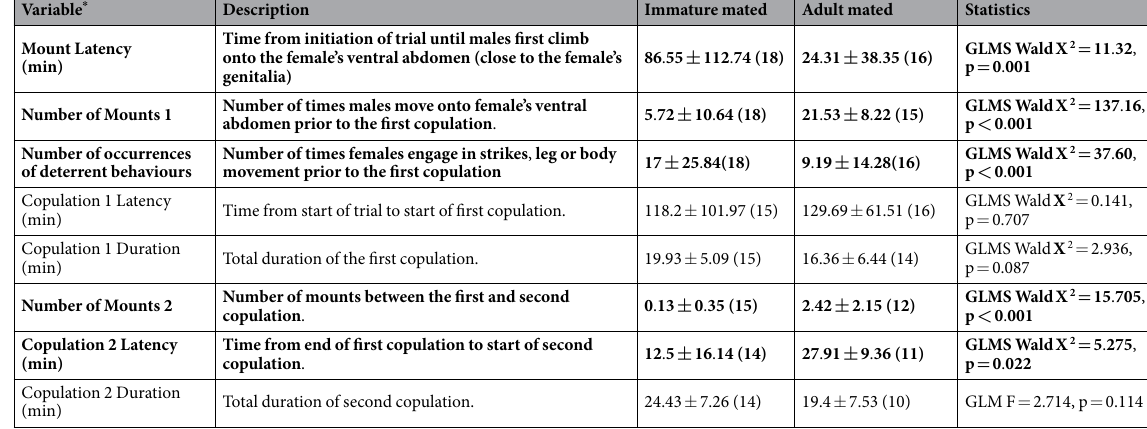
Table 1. Description and comparison (mean ± s.d.) of male and female-initiated behaviours and mating outcomes scored for pairings between adult males and immature or adult females. * Variables in bold differ significantly between the two